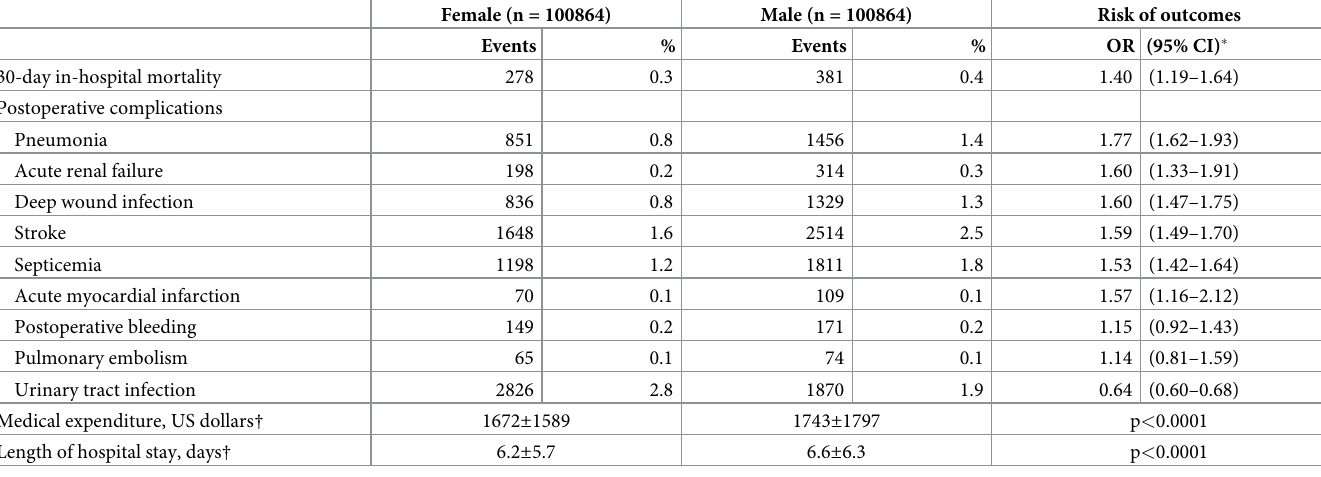
Table 3. Risk of complications and mortality after fracture for female and male